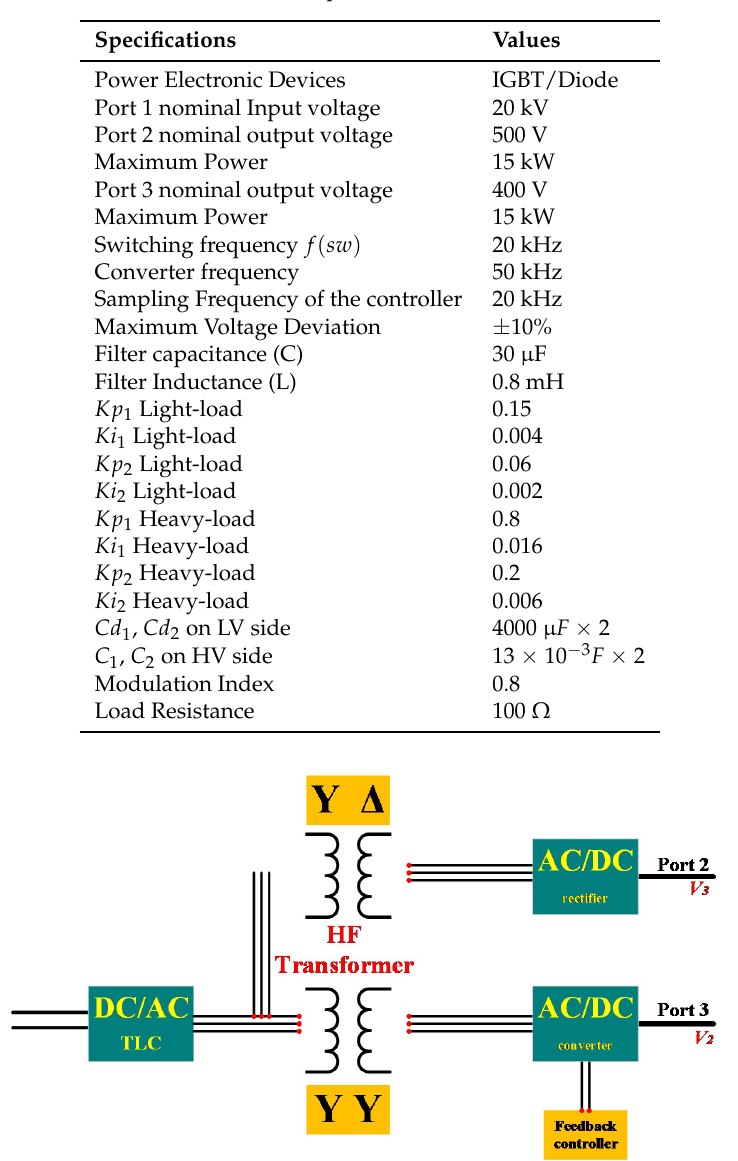
Table 1. Converter parameter of the simulation.